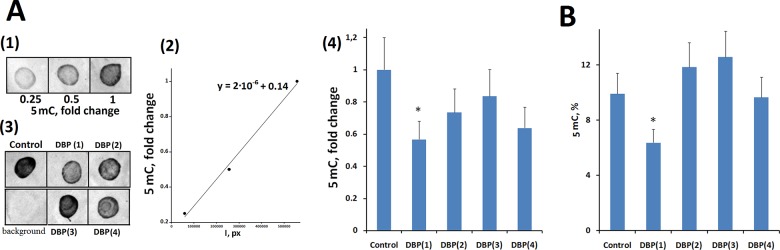
Overall 5-methylcytosine level in DNA of cells treated with 20 μM DBP(1–4) for 72 hours.A (ELISA). (1, 2)–example of calibration dependence between methylated DNA in samples and integral stain density (I). (3) example of DNA samples analysis from cells treated with DBP(1–4). 10 ng of DNA was applied. pBR322 plasmid was used as a negative control. (4) Relative signal change reflecting difference in DNA methylation level. B (UPLC/MS/MS). Average 5mC content in DNA samples.